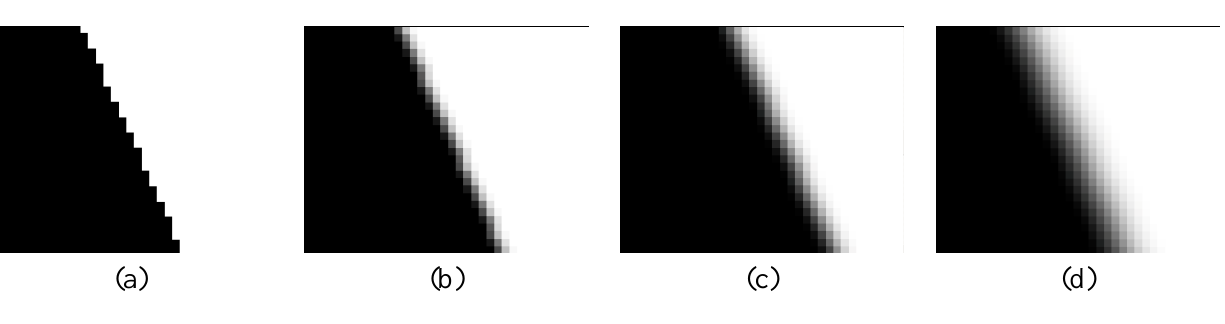
Figure 11. Example of slanted-edge with a blurring level progressively stronger: (a) No blurring; (b) 0.5 pixel mask; (c) 1.0 pixel mask; (d) 2.0 pixel mask. The edge has been zoomed in this figure for the sake of intelligibility. No re-sampling has been done on the raw